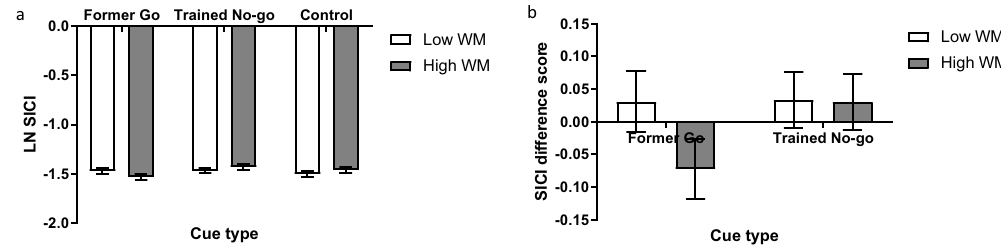
Figure 4. ( a ) SICI represented as mean log(paired-pulse MEP/single-pulse MEP) by working memory and cue type. ( b ) Mean SICI difference scores from the control cue by working memory and cue type. Error bars represent within participant standard errors across working memory conditions separately for each cue type.